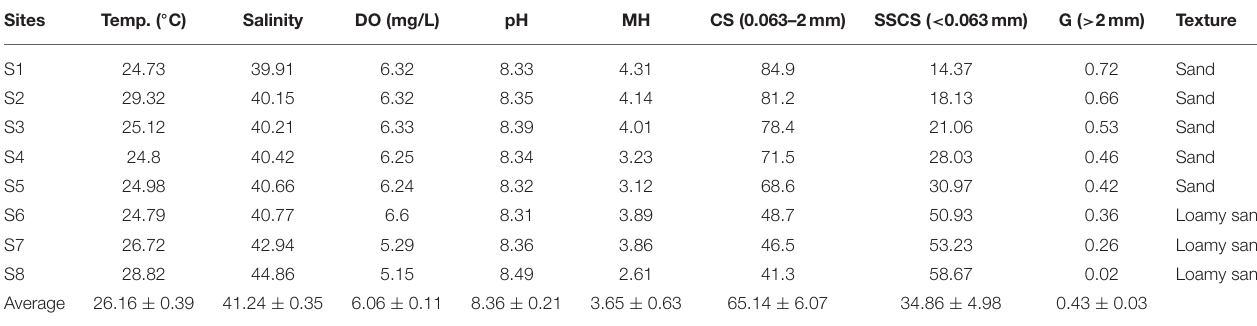
TABLE 1 | Physicochemical properties of seawater and average mangrove height at different sites in Rabigh Lagoon. Sites Temp. ( ◦